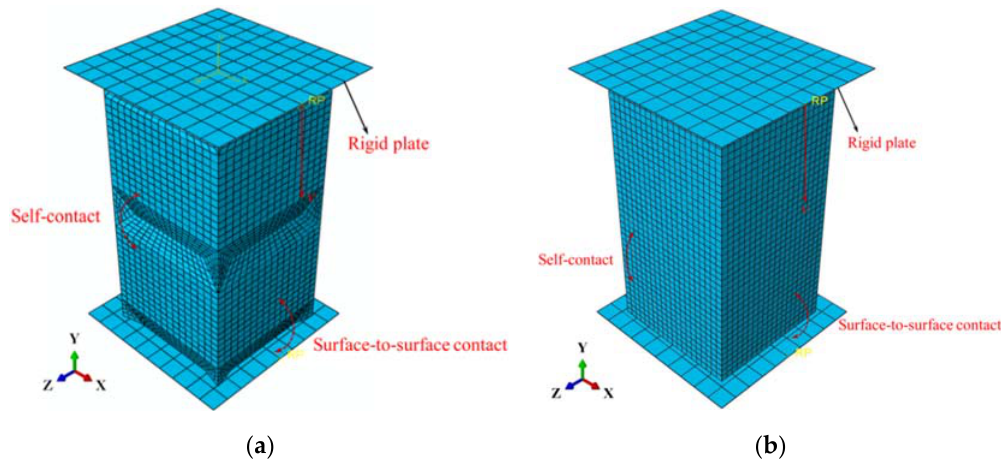
Figure 3. ( a ) Finite element model of the OET; ( b ) finite element model of the CST. Table 1. Experimental parameters of FFF 3D ‐ printed PLA tensile specimens.